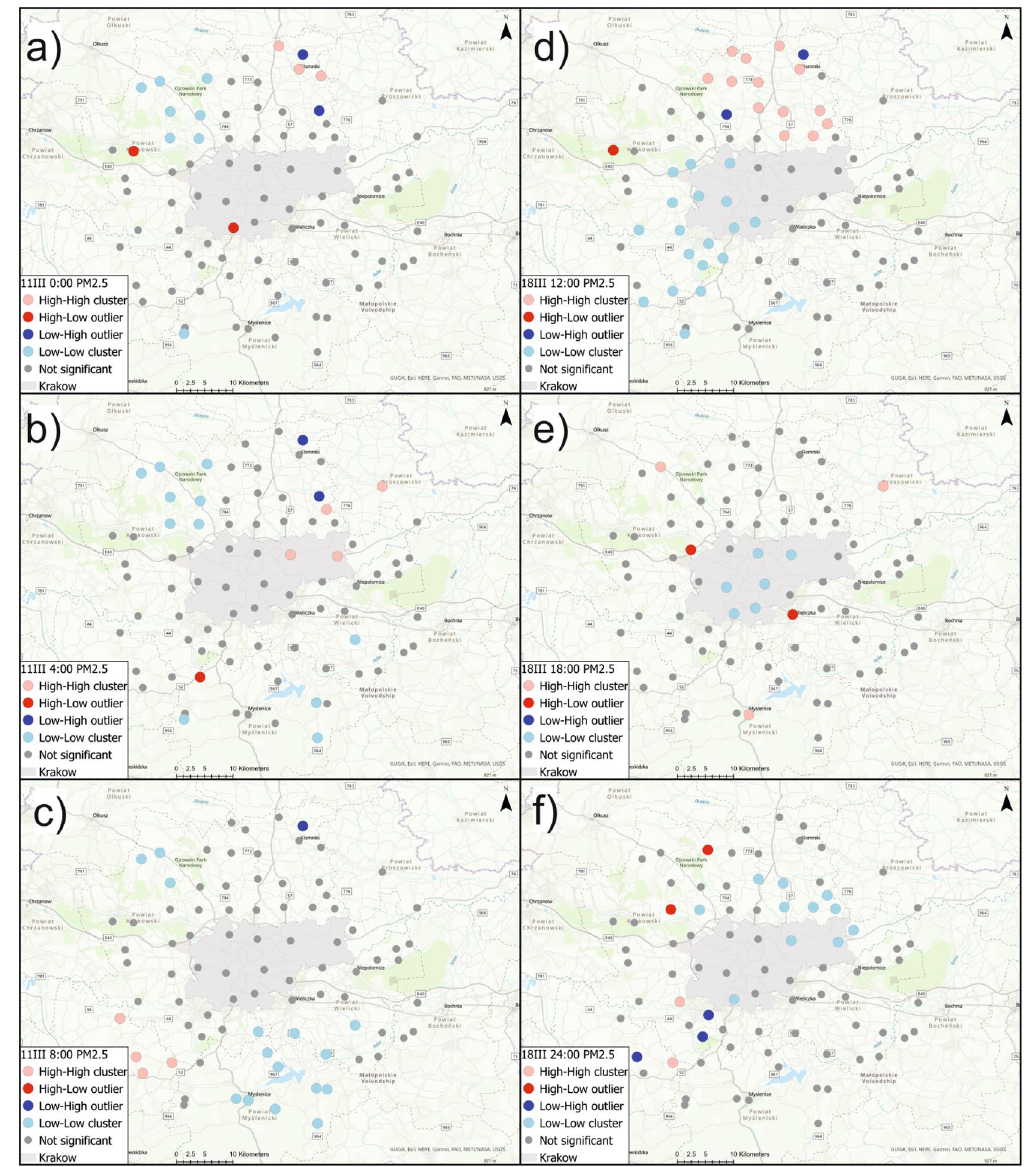
Figure 6. Local Moran’s I cluster maps showing high-high, low-low, low-high, and high-low spatial associations for PM2.5 concentration on March 11th and March